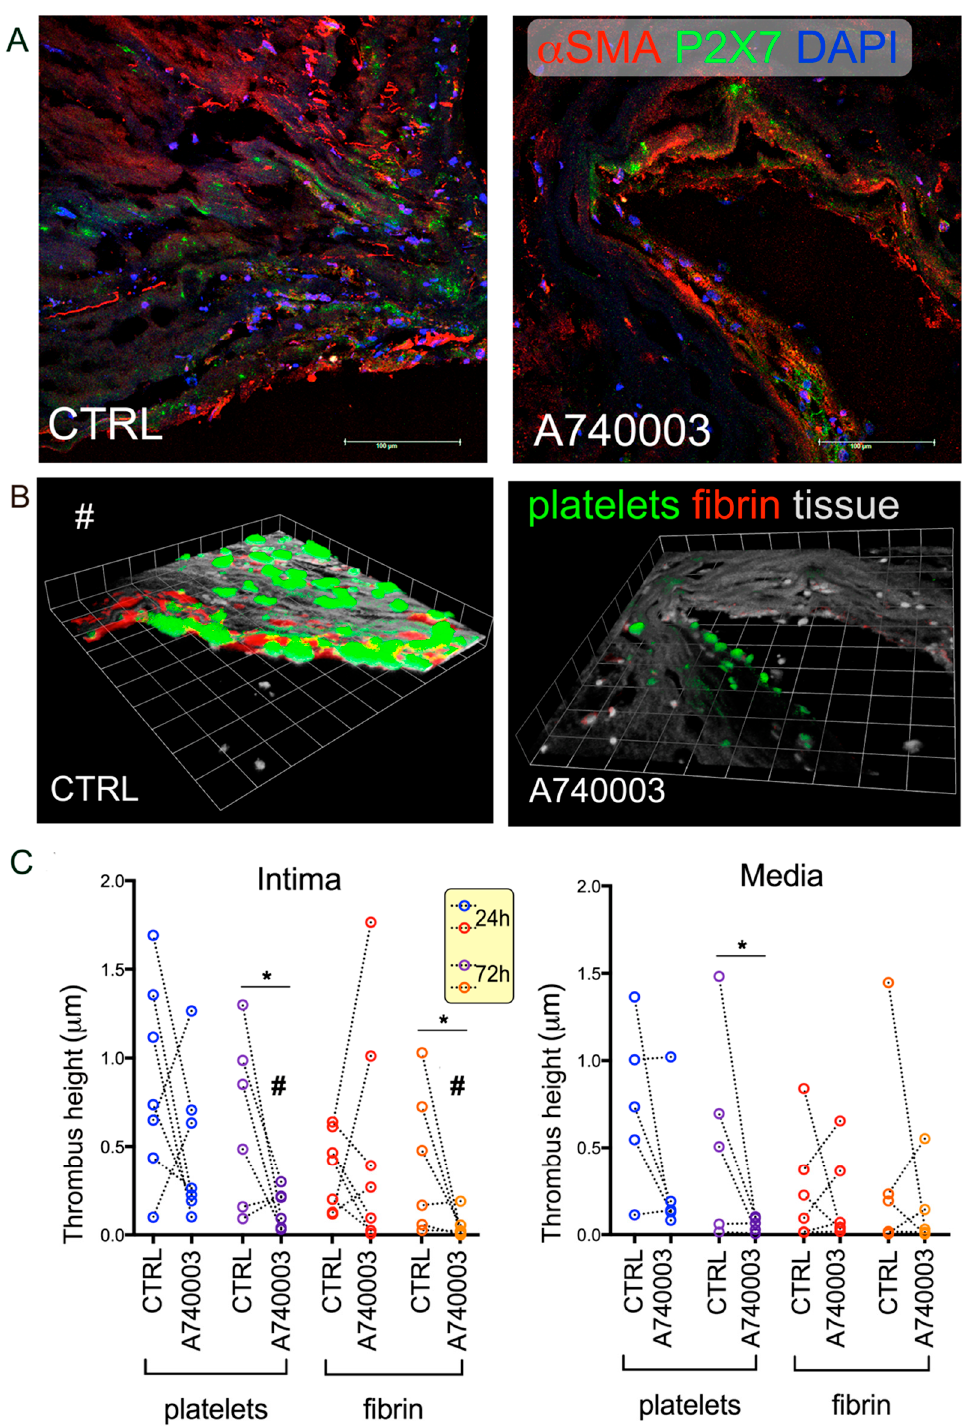
Figure 5. Effect of P2X7 antagonism by A740003 on thrombus formation over CPL intima and media. Representative intima fields from carotid artery plaque (CPL) in confocal images showing the expression of α SMA (red) and P2X7 (green). Nuclei are stained with DAPI (blue) ( A ). The same fields are displayed in 3D rendering images from confocal Z sections, with colorized platelets and fibrin ( B ). Quantitative analysis of thrombus formation over intima ( C , left) and media ( C , right) of 6 CPL pre-treated ex vivo with A740003 (t24 h and 72 h of treatment in tissue culture, respectively), sectioned and perfused with control blood shows is presented. Data from at least 5 single fields are presented as before–after dot plot with dotted lines connecting the fields with the same X, Y. The symbol # indicates the same intima field in ( A – C ); * p < 0.05 by t -test.